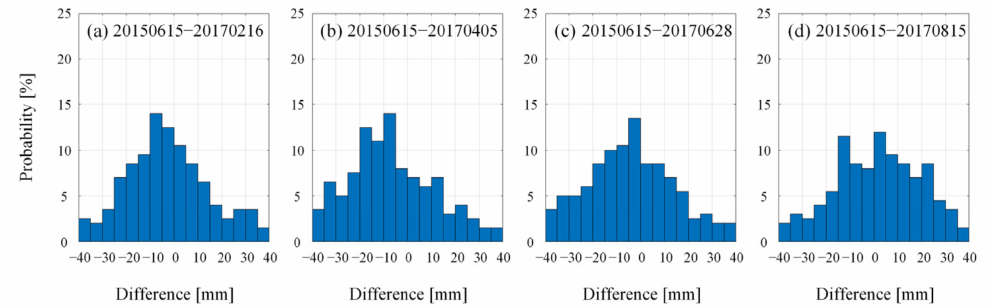
Figure 17. Differences of static PIM predicted subsidence with comparison of SBAS-InSAR results (with reference to 15 June 2015).